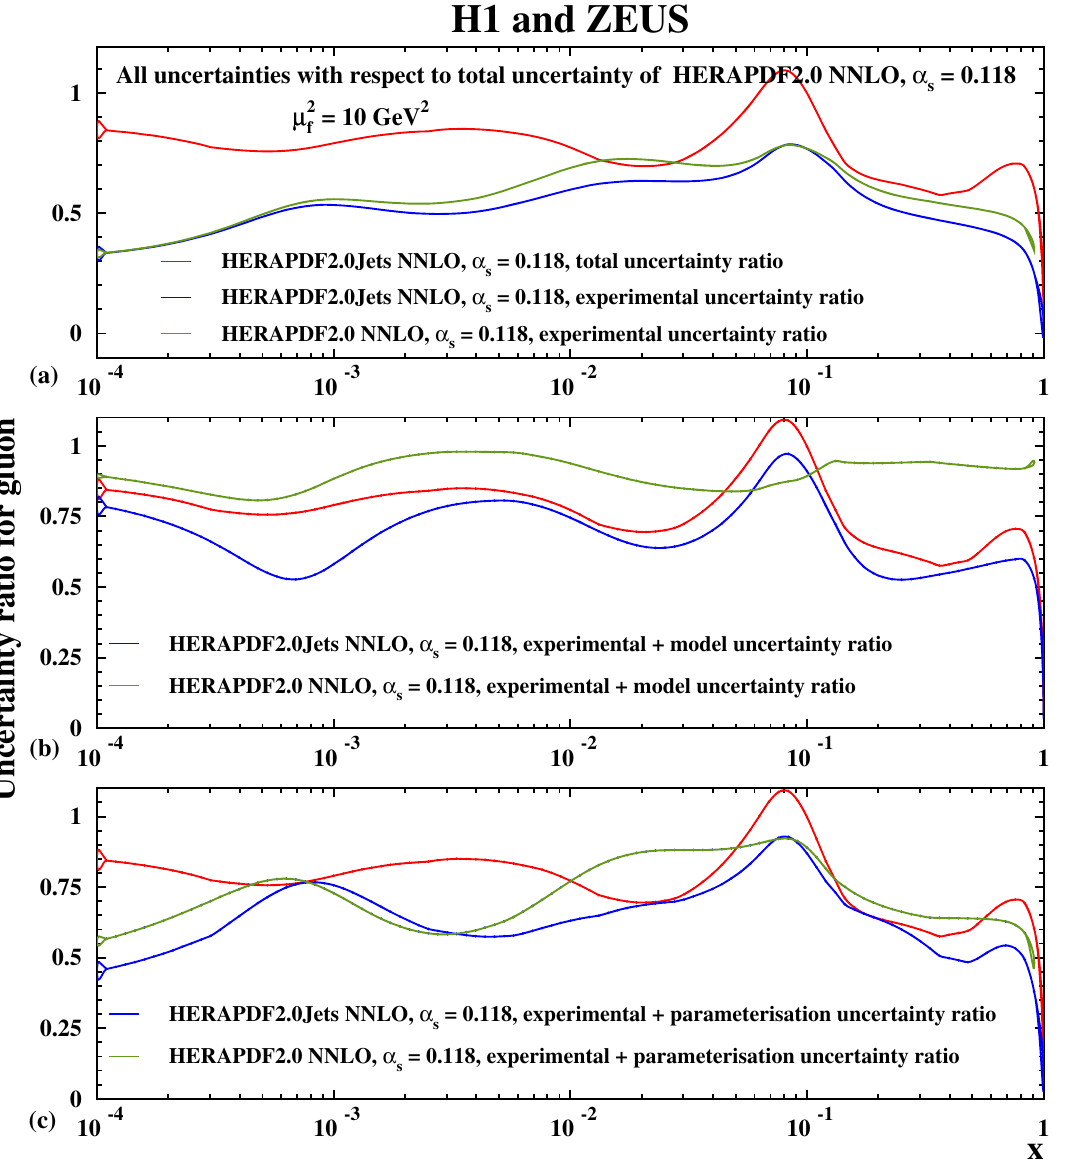
) = 0 . 118 Z ) = 0 . 118 at the scale Z